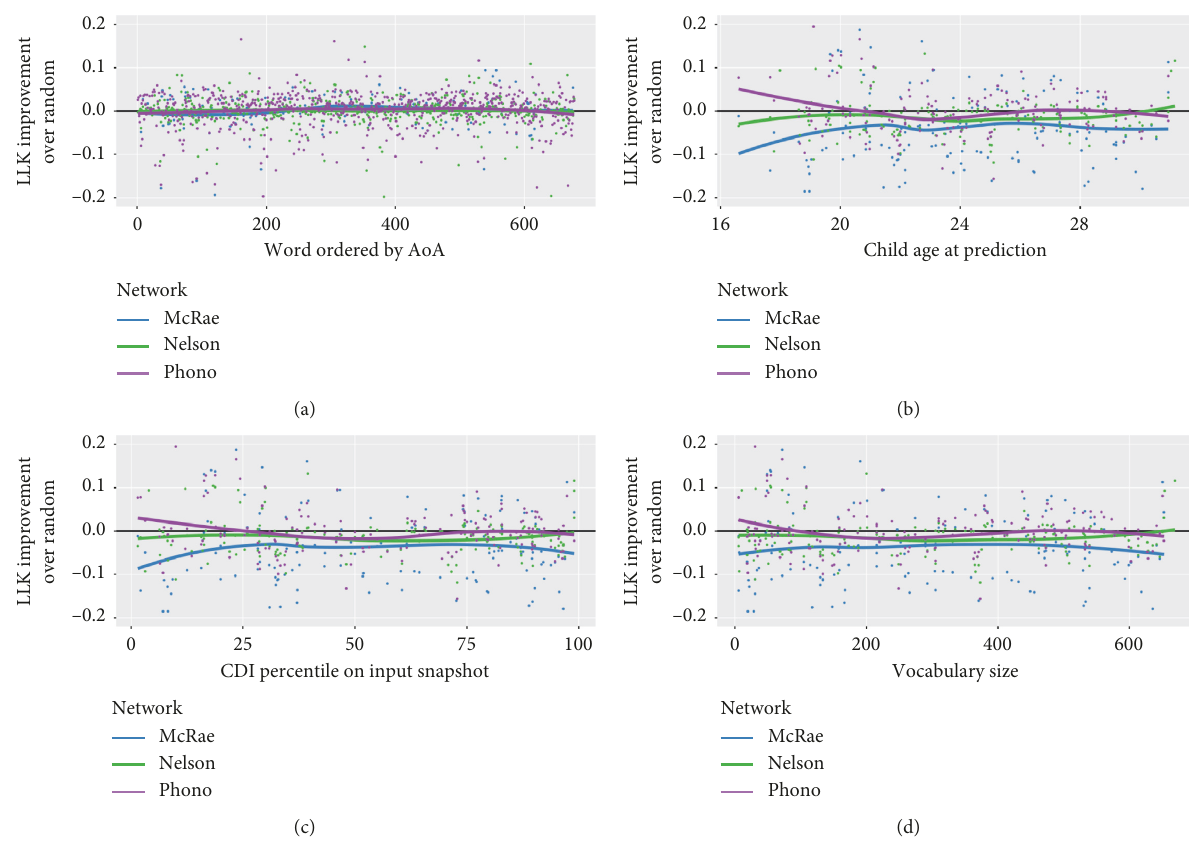
Figure 6: We consider performance of the best performing network growth models when sorted by average age of acquisition (AoA) (a) the child’s age (b), CDI percentile (c), and vocabulary size (d). The lines indicate a locally weighted smoothing of the difference between each model’s individual CDI baseline and the network model fit. Positive values indicate systematic improvement over the baseline CDI model for the population of snapshots in our test data. The points are individual differences that are used to compute the smoothed